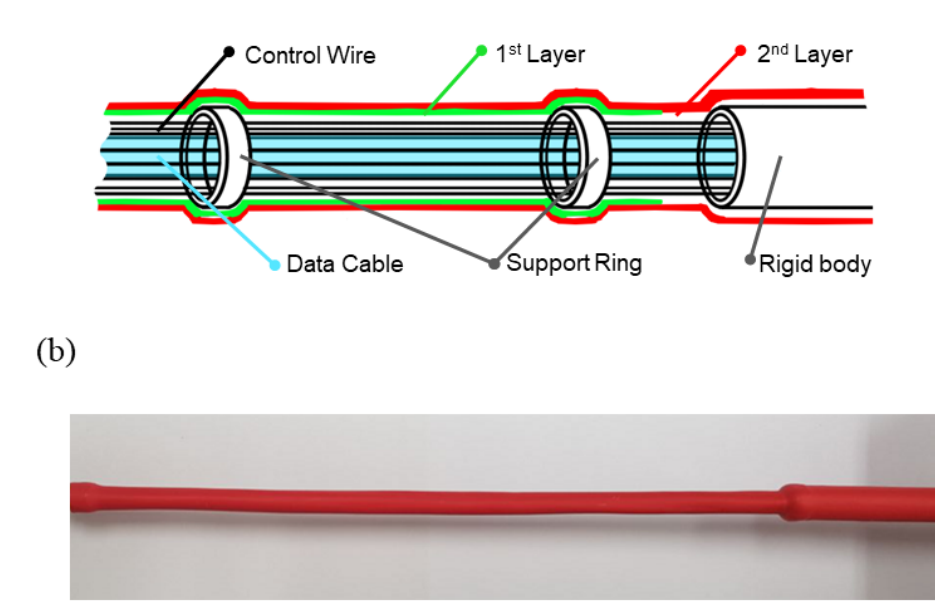
Figure 5. Flexible segment of the endoscope module: (a) structure of the flexible segment, designed to flex to the curvature of the organ and also